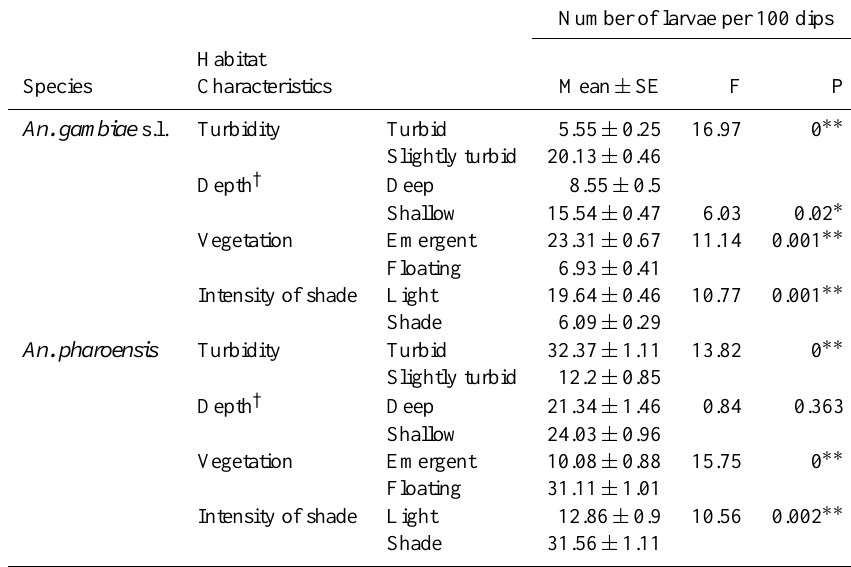
Table 2. Physical habitat characteristics and mean larval density (no. of larvae per 100 dips) of An. gambiae s.l. and An. pharoensis in